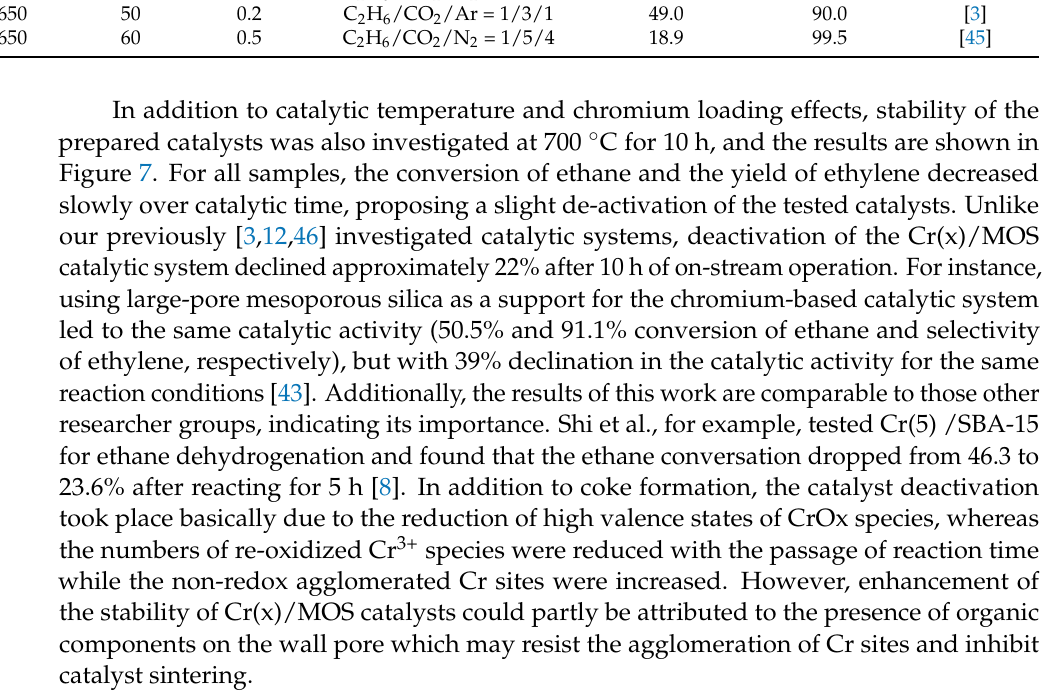
Table 3. Comparison of different catalysts in the dehydrogenation of ethane with CO 2 .